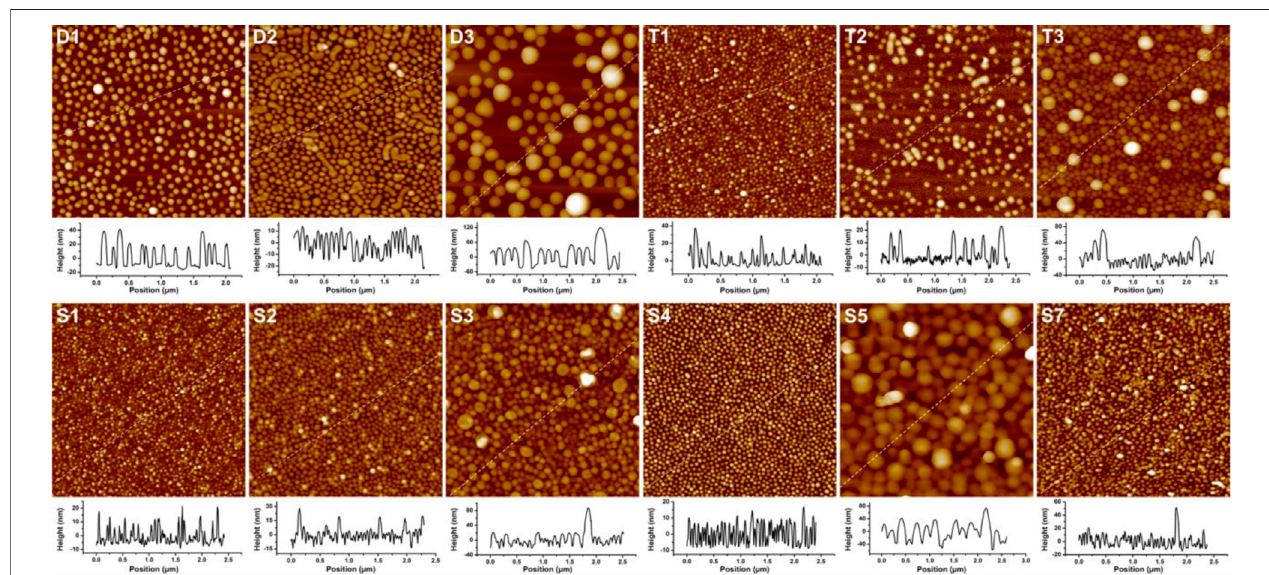
FIGURE 1 | AFM height images (2 μ m × 2 µm) and section analyses for linear and star BCPs adsorbed on surfaces. The Z scale of the AFM images is 100 nm for (D1), 60 nm for (D2, T1, T2, S1, S2 and S7), 280 nm for (D3 and S5), 200 nm for (T3), 120 nm for (S3), and 40 nm for (S4). The IDs inset ineach panel correspondto the sample IDs used in Table 1 .